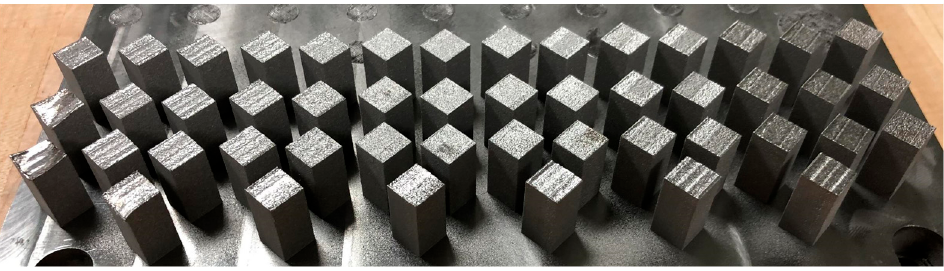
Figure 6. Build plate with iron specimens.